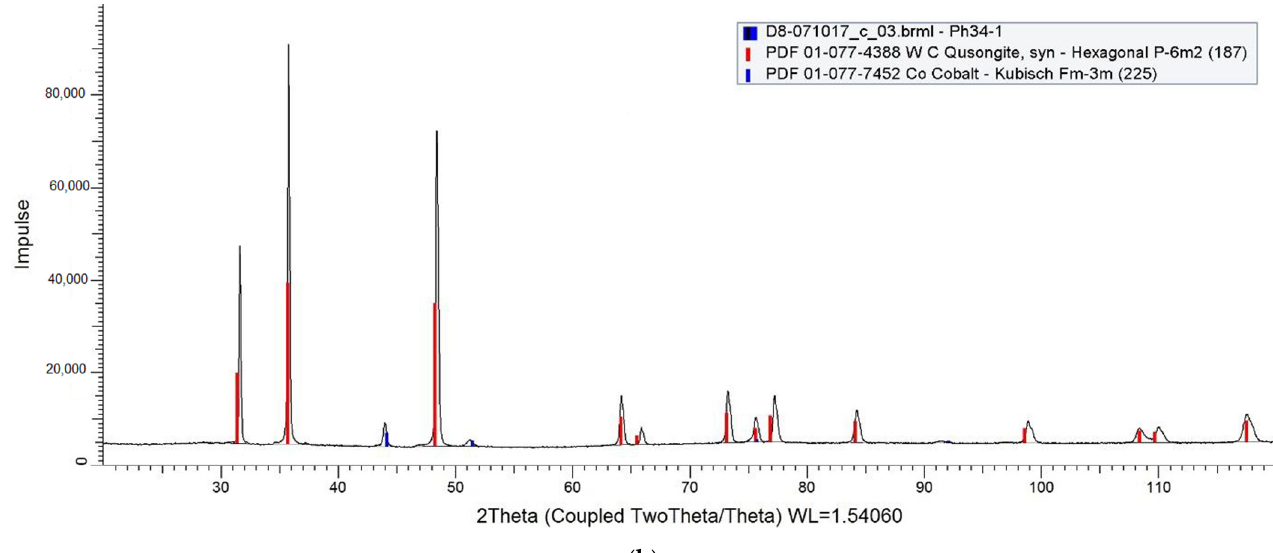
Figure 3. Microstructure and XRD pattern of WC-15Co sample [20]: ( a ) SEM image of microstructure; ( b ) XRD pattern.